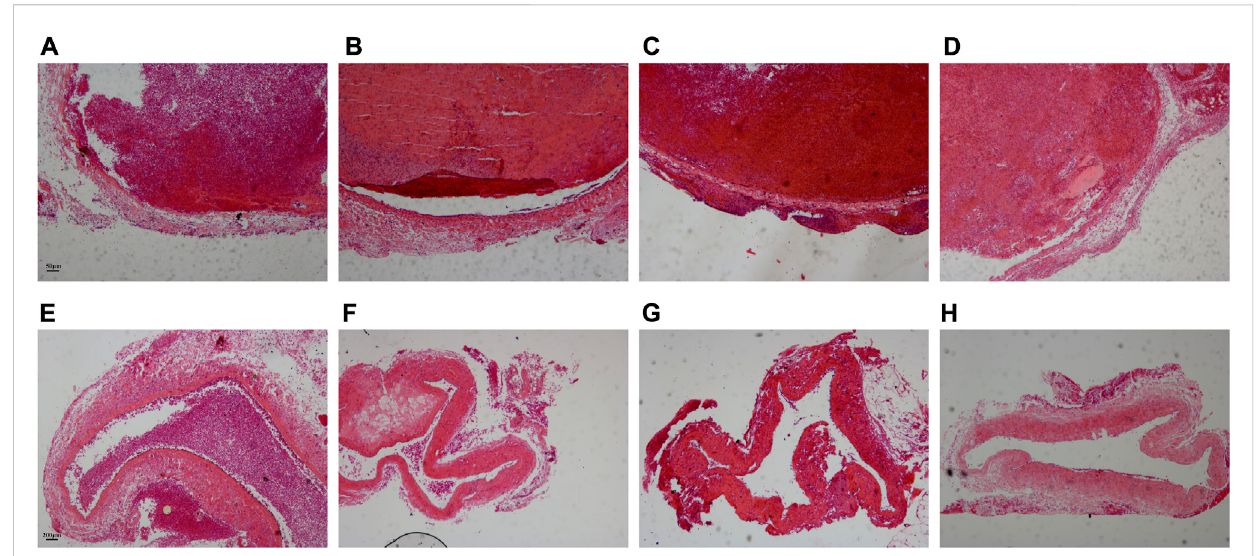
FIGURE 4 Comparison of pathological results of the thrombus before and after treatment. (A – D) Corresponded to the Group I-IV before treatment. Scale bar = 50 μ m. (E – H) Corresponded to the Group I-IV after treatment. Scale bar = 200 μ